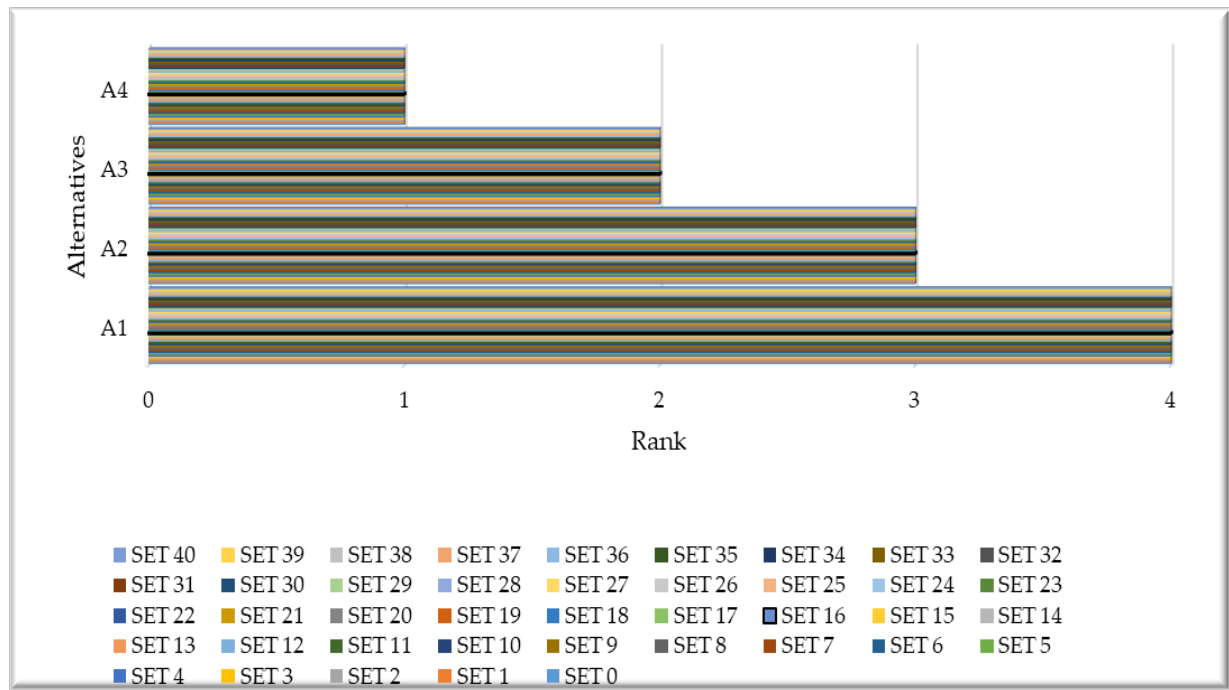
Figure 7. Order-picking technology rankings with new criterion weights.